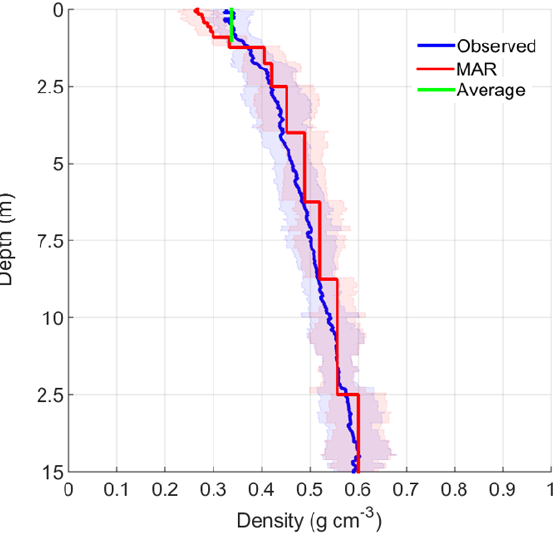
Figure 2. Mean observed (blue) and MAR modeled (red) densi- ties profiles with 1 standard deviation (shaded regions), showing an underestimation of modeled densities in the top 1m of snow/firn. The mean observed density in the top 1m (green) was used with the modeled densities below to create a hybrid measured–modeled den- sity profile. The locations of the density measurements are shown in Fig. 1 and the measurements and modeled profiles are contempora-